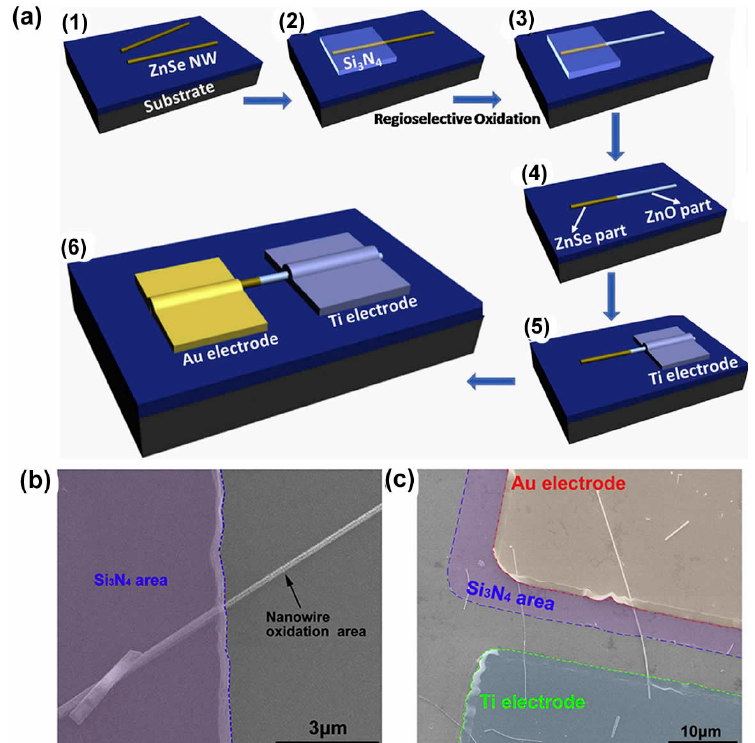
Figure 6. ( a ) Schematic illustration of the construction process of the ZnSe-ZnO axial p-n junction. ( b ) The SEM image of a nanowire whose bare part has already been oxidized. ( c ) The SEM image of a prepared ZnSe-ZnO nanowire axial p-n junction. Reproduced with permission from [39],